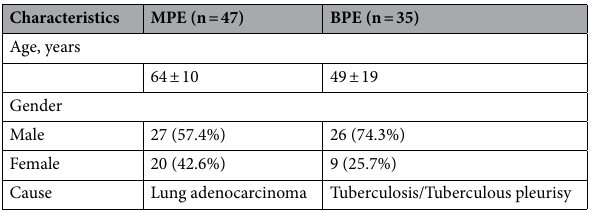
Table 1. Demographic and clinical characteristics of malignant pleural effusion (MPE) and benign pleural effusion (BPE)